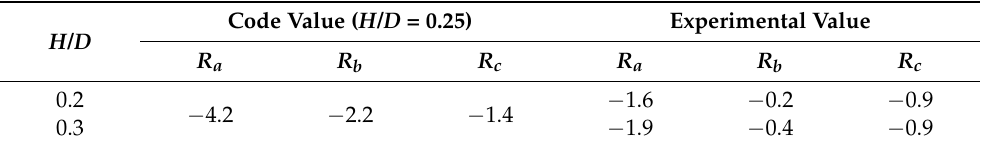
Table 7. Comparison of code value according to code area and C pn,min of open ratio = 30% [22]. Code Value ( H / D = 0.25) H / D